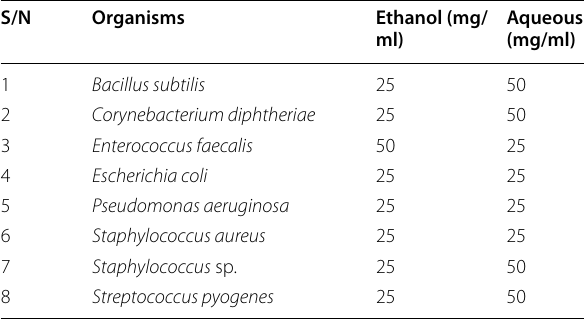
Table 8 Minimum inhibitory concentration of ethanoic and aqueous extracts of Vernonia amygdalina